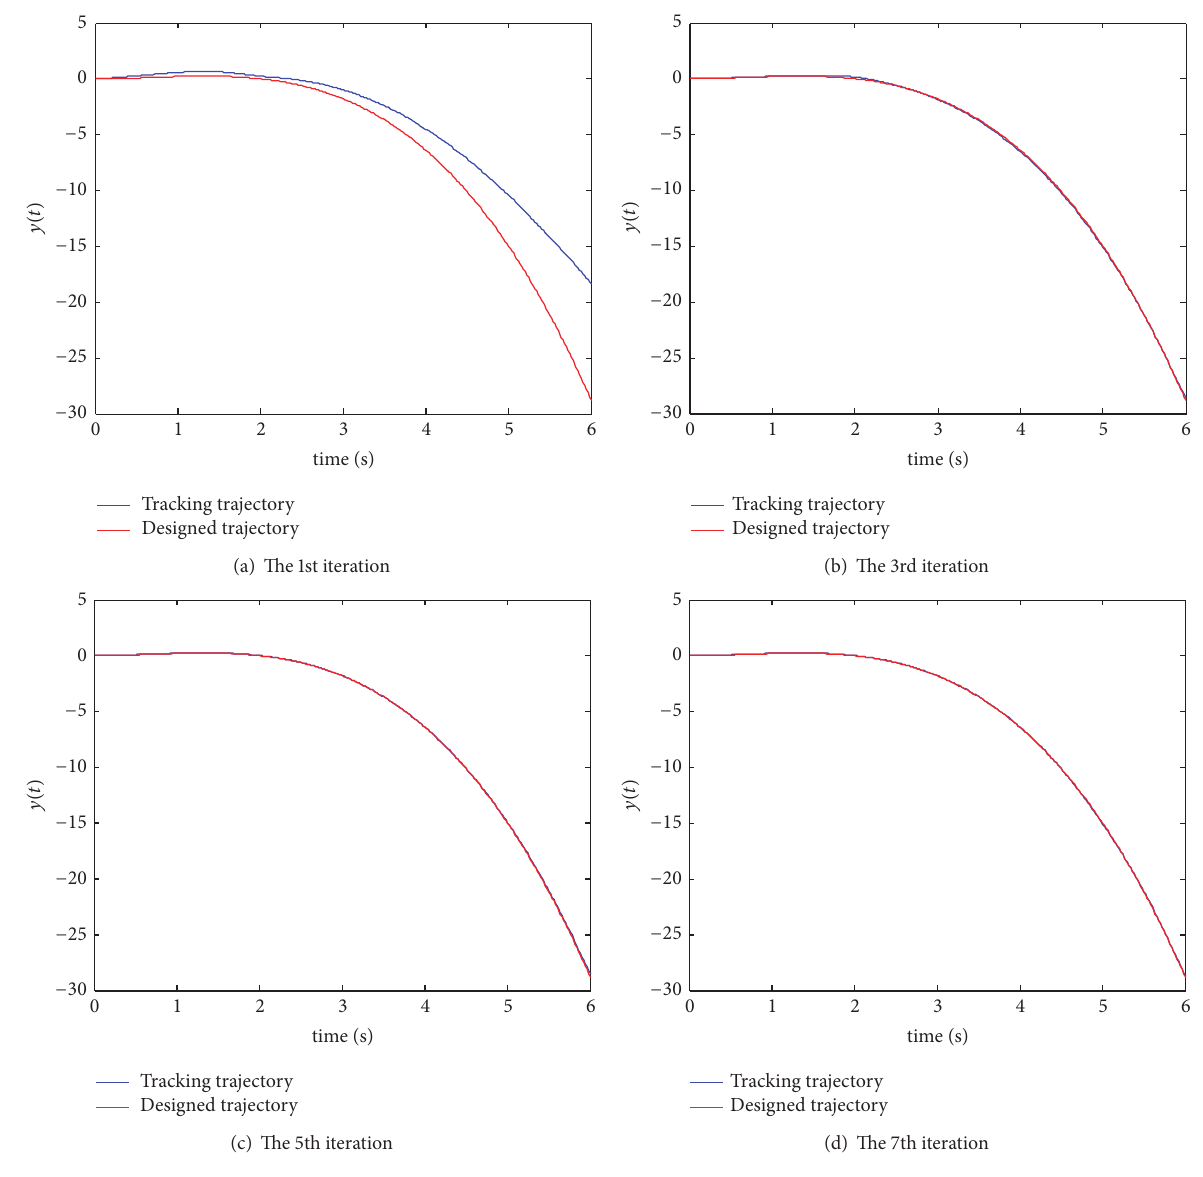
Figure 1: Tracking of the